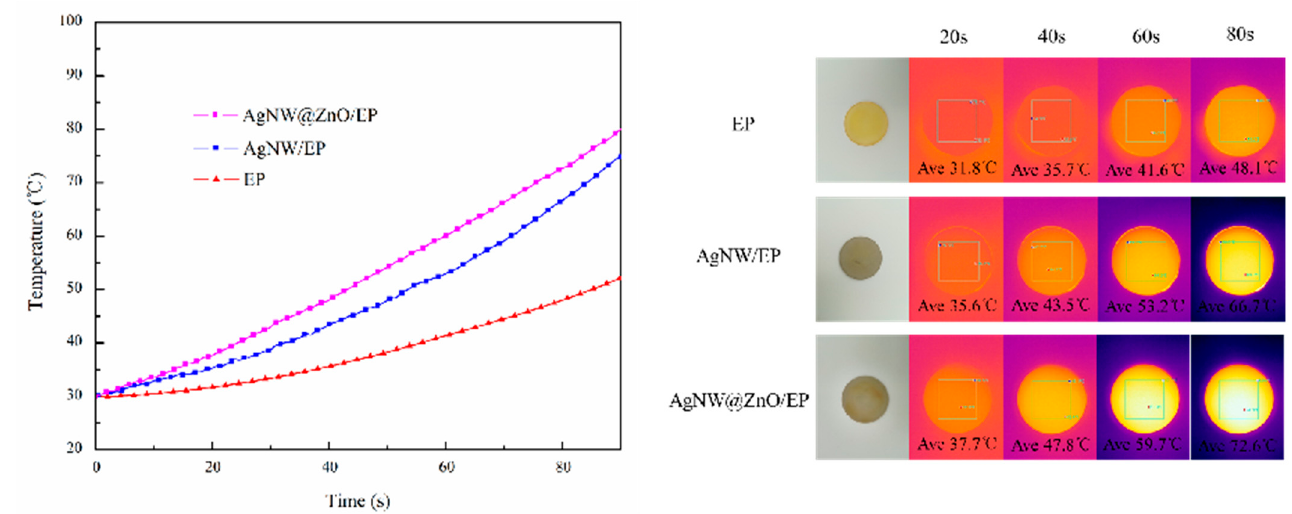
Figure 9. Surface temperature curves and corresponding infrared images of AgNW/EP and AgNW@ZnO/EP composites. AgNW@ZnO/EP